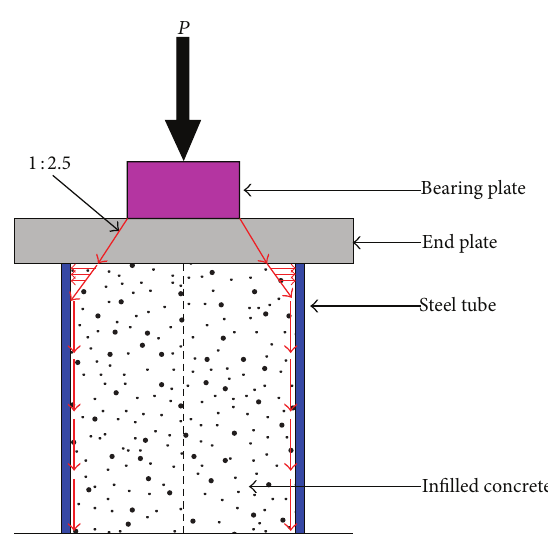
Figure 5: Load transferring mechanism of partial and full compres- sion